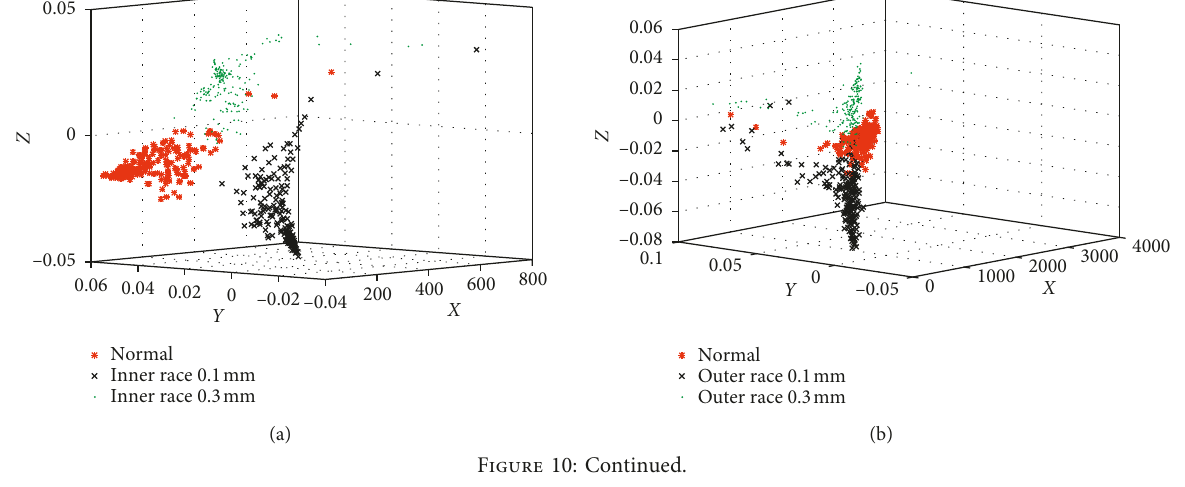
Normal Inner race